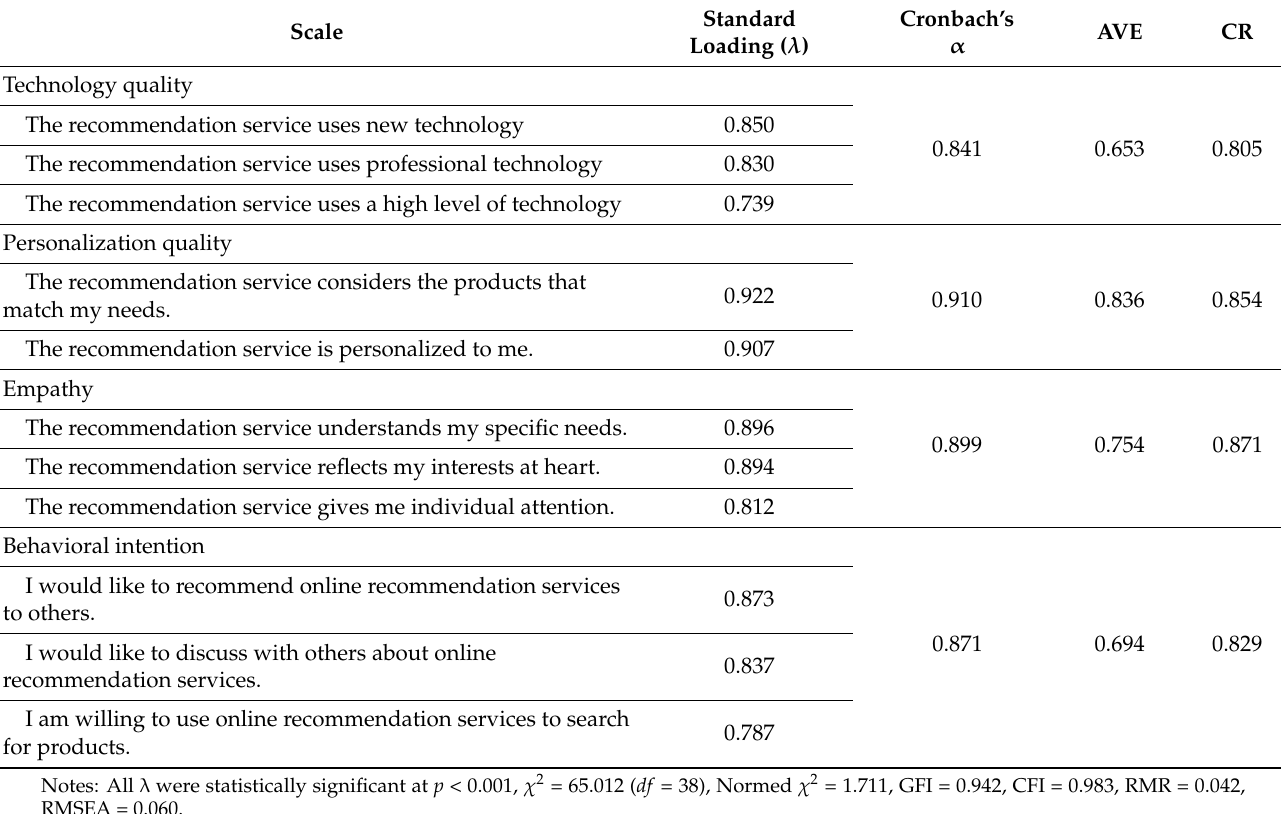
Table 1. Measurement model.